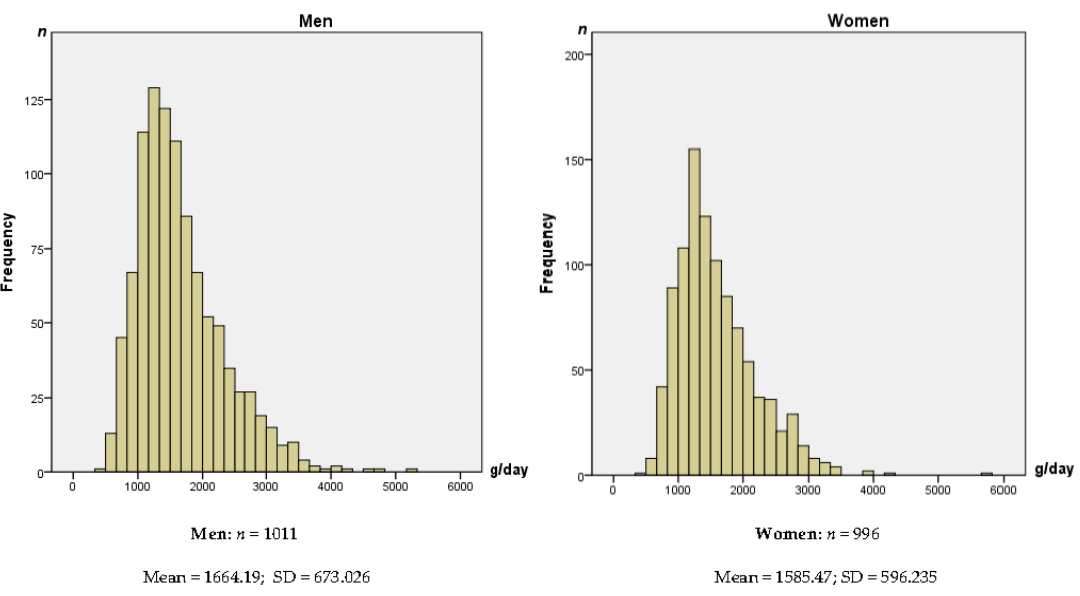
Figure 1. Frequency distribution of total water intake (g/day) over three days by gender. Percentages of total weight consumed (g/day), daily EI (kcal/day), and water intake (g/day)